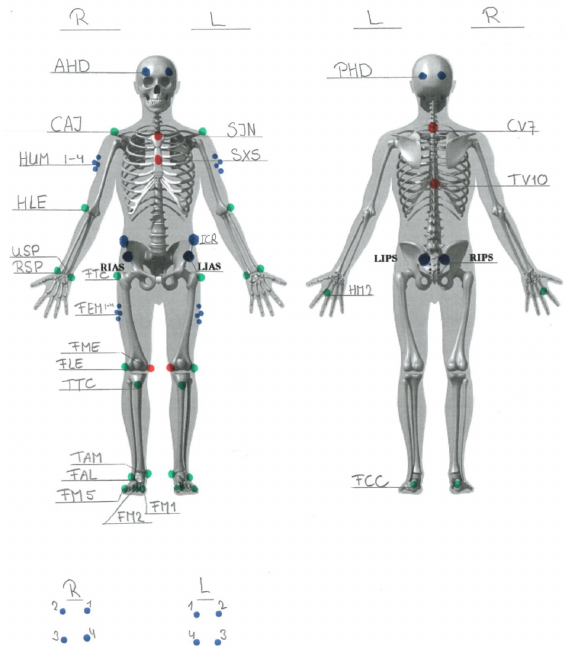
Figure A1. Illustration of the placement of the reflective markers for the full-body model in the Qualisys track manager software, this figure is reprinted with permission [48].